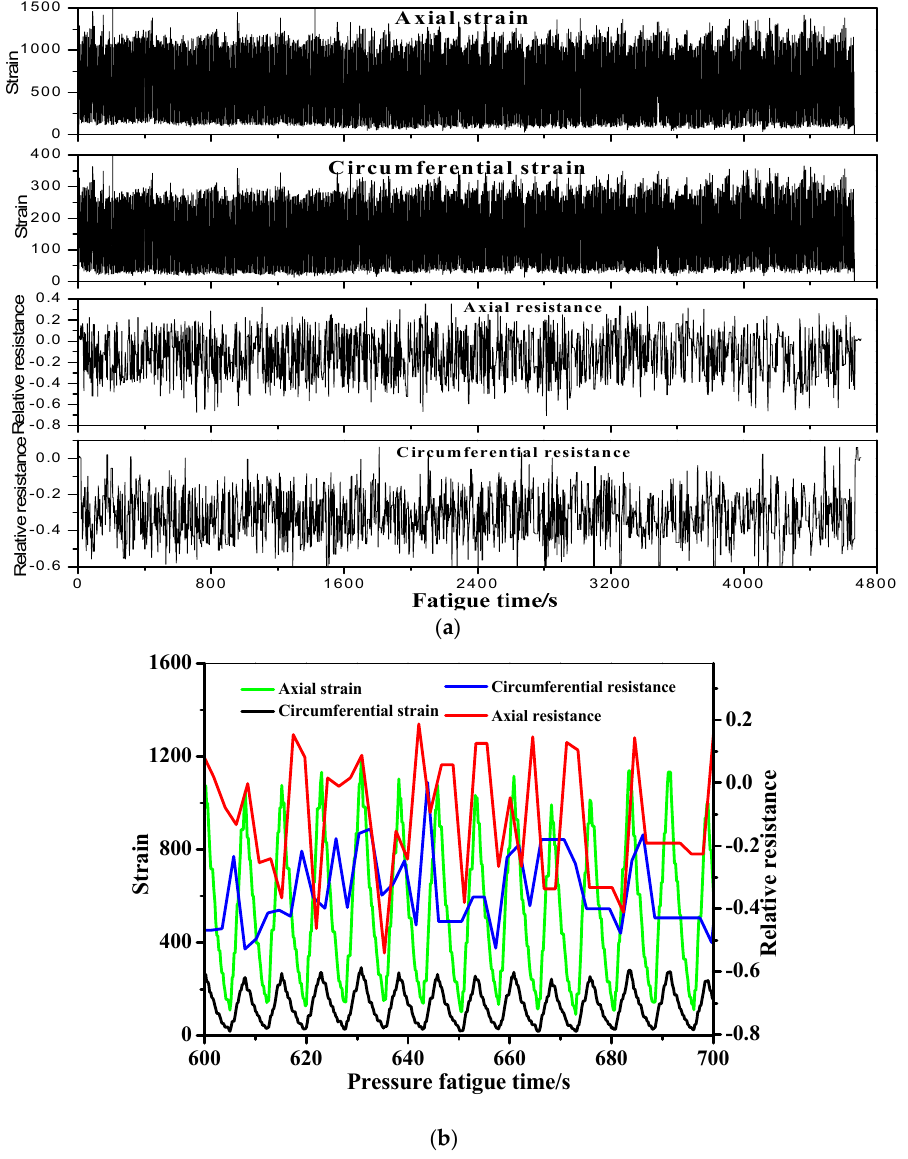
Figure 13. Monitoring results by the MWCNT sensor and the stain gauge when the filament wound pressure vessel is in 5100- to 5700-fatigue cycles. The strain was measured by strain gauge-2 in Figure 4. ( a ) Resistance, the stain as the function of fatigue time. ( b ) The enlarged drawing curves. Table 3. The equivalence relationship between the resistances tested by the embedded MWCNT sensor and the strain